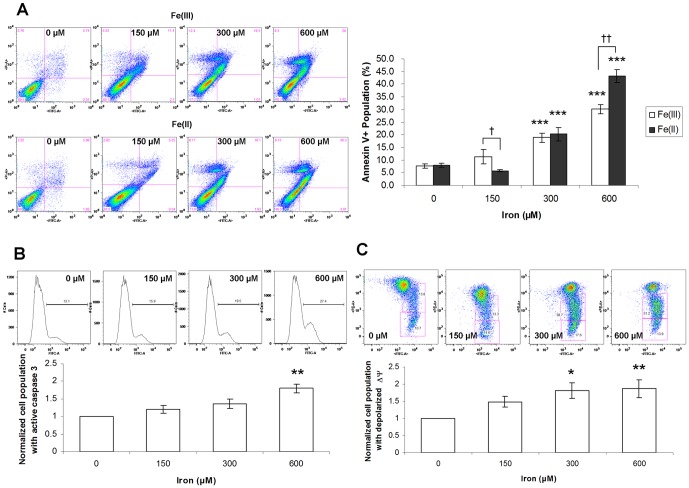
Iron overload induced cardiomyocyte apoptosis.HL-1 cells were treated with Fe(III) and Fe(II) for 72 hr, followed by (A) annexin V/PI flow cytometry assay, (B) active caspse-3 flow cytometry assay, and (C) JC-1 flow cytometry assay. *, †, p<0.05; **, ††, p<0.01; ***p<0.001; * versus respective controls. The results represented as mean ± SEM of five to six independent experiments.